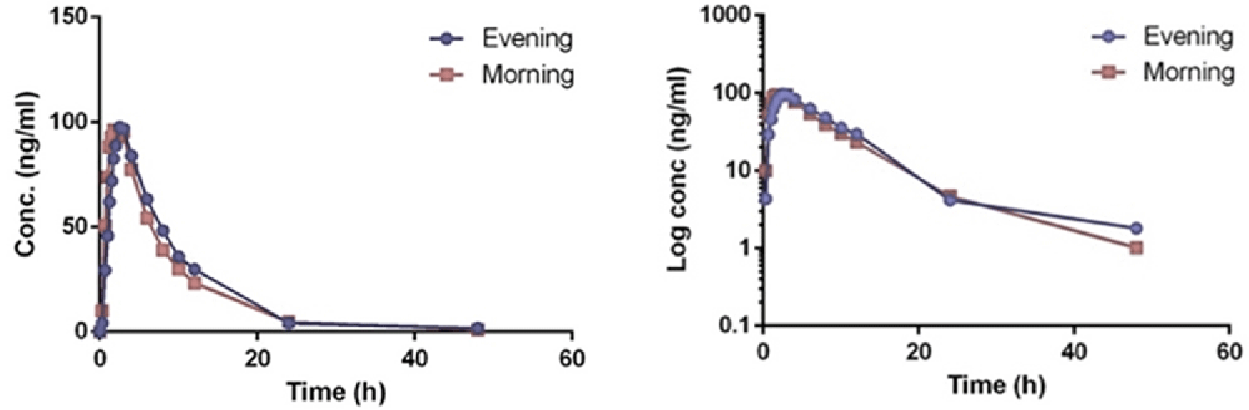
Figure 4. Linear (left panel) and semi-logarithmic plot (right panel) for average empagliflozin 10 mg plasma concentration (ng/ml) after evening (phase 1) and morning (phase 2)